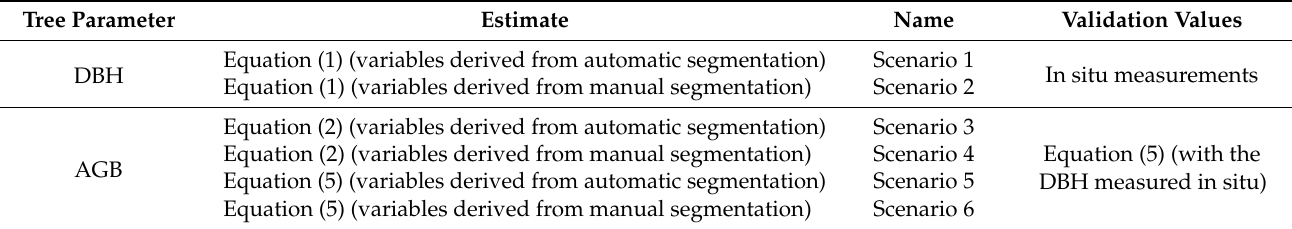
Table 1. The validation procedure summary and scenario nomenclature. Tree Parameter Estimate Name Validation Values Scenario